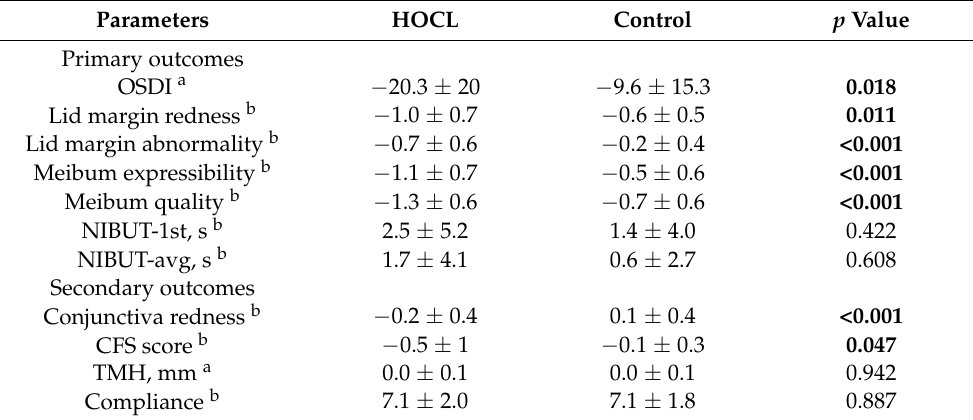
Table 2. Comparison of improvements in ocular surface parameters after 2 weeks treatment and patient compliance between hypochlorous acid group and control group.